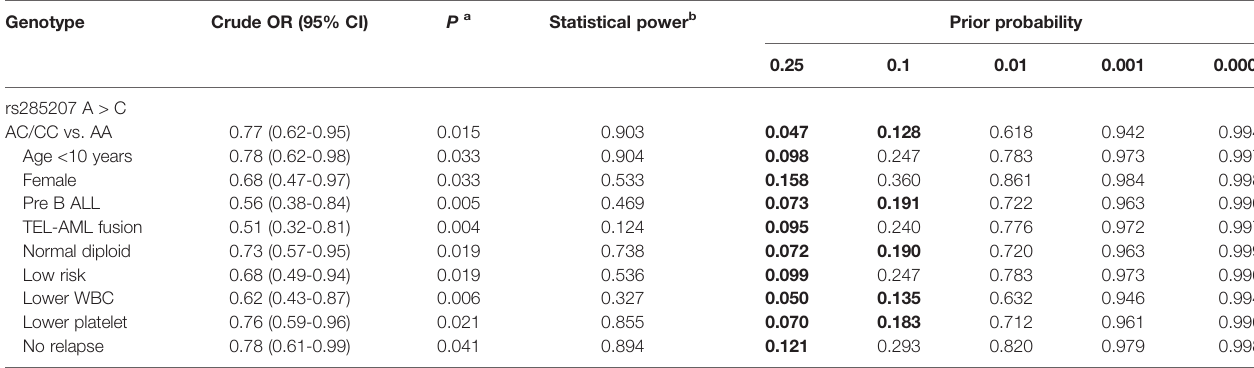
TABLE 5 | False-positive report probability analysis for the signi fi cant fi ndings. Genotype